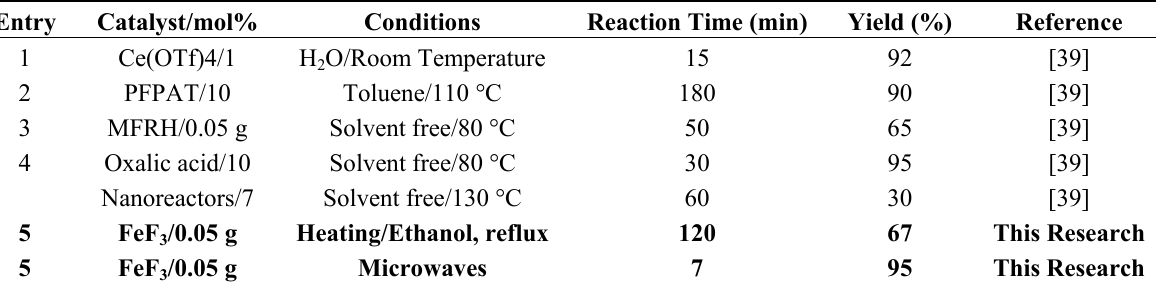
Table 4. Reaction of resorcinol with ethyl acetoacetate (Table 1, Entry 4) in the presence of different catalysts.